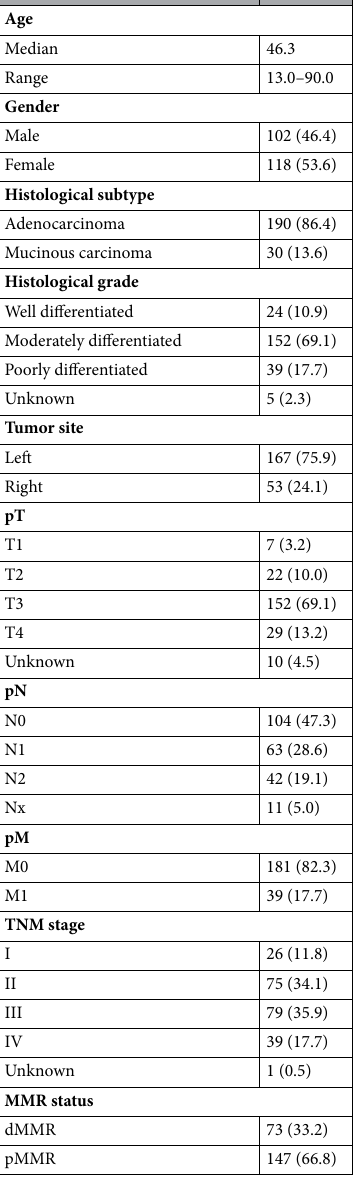
Table 1. Clinico-pathological variables for the patient cohort (n =